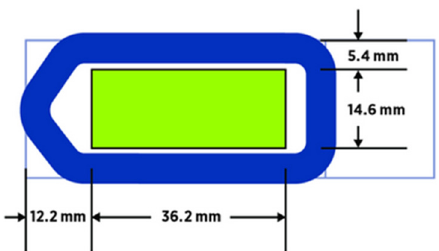
Figure 2. Slide dimensions and tissue placement for GeoMx DSP study. Tissue sections must be placed in the digital scan area (shown in green), measuring, at maximum, 36.2 mm long by 14.6 mm wide in the center of the slide. The tissue sections should not overlap the slide gasket (shown in blue) or the tip calibration area (the triangular region to the left of the green scan area). The frosted/label end of the slide is on the right.